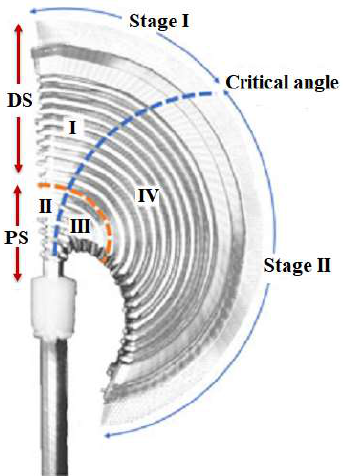
Figure 4. Four areas of deflection for sinus surgical continuum robot. Table 2. D-H parameters of a continuum surgical robot: stage I ( θ ≤ 90 ) and stage II ( 90